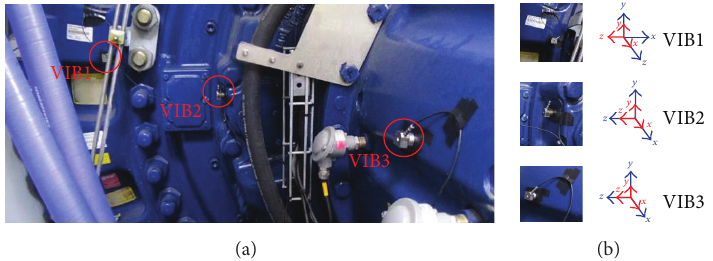
Figure 13: Sensors attachment on the gearbox: (a) set-up and (b) global (red) and local (blue) axis.